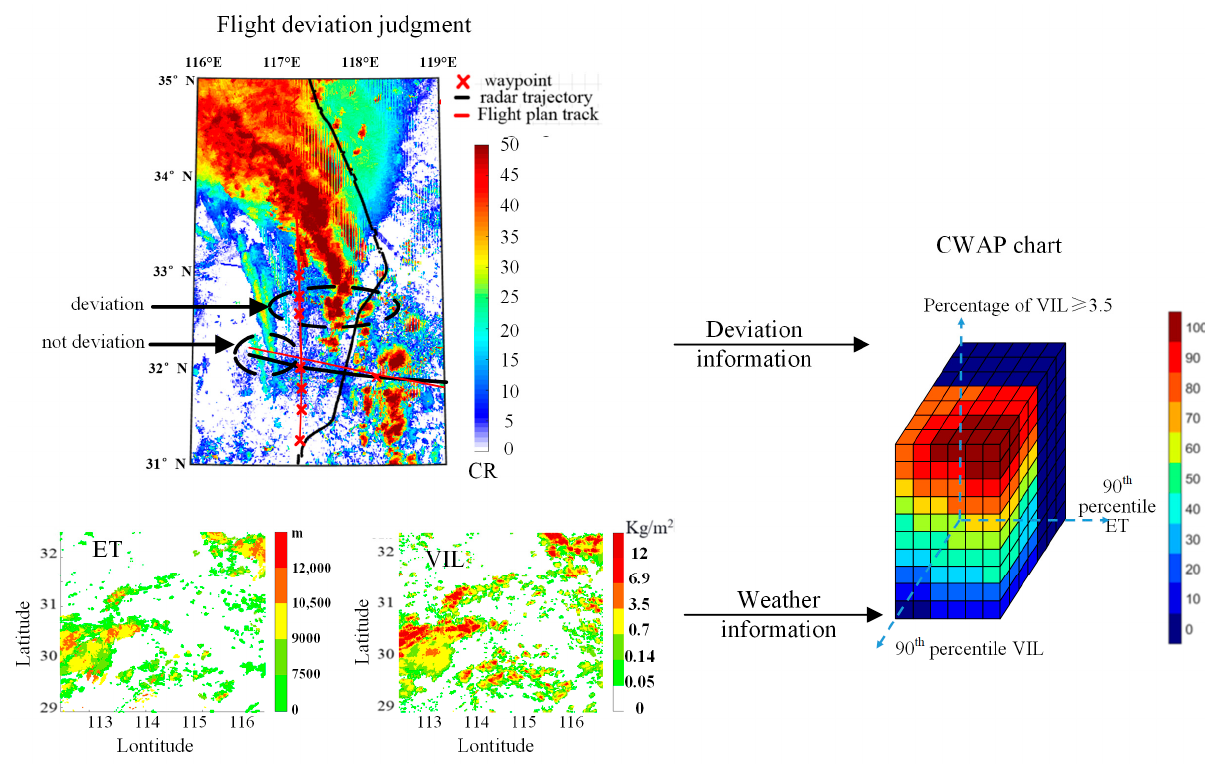
Figure 2. The process of CWAP chart.